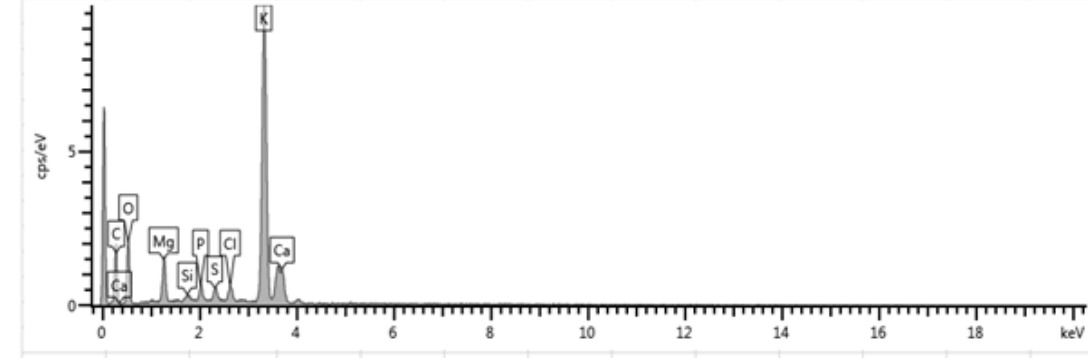
Figure 1. EDX plot of calcined CPK ash at 500 °C.